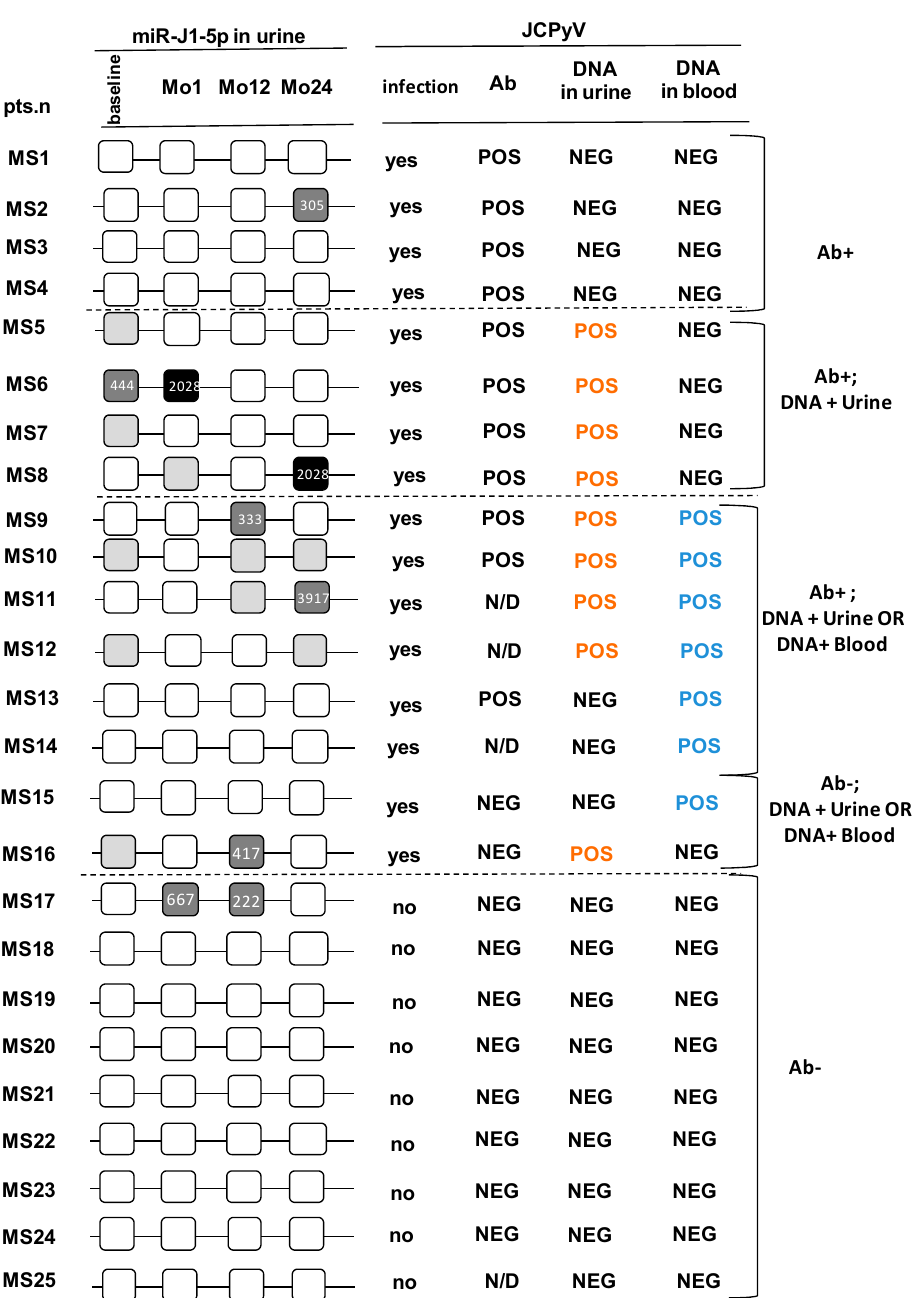
Figure 2. miR-J1-5p and JCPyV DNA detection in urine samples of Natalizumab-treated Multiple Sclerosis patients. Black boxes: positivity for both miR-J1-5p and JCPyV DNA; dark grey boxes: miR-J1-5p positivity alone; light grey boxes: JCPyV DNA positivity alone; white boxes: absence of both nmiR-J1-5p and JCPyV DNA. miR-J1-5p copies/ng are indicated inside the boxes. In the right columns the presence of anti-JCPyV Antibodies (Ab) and JCPyV DNA for each patient is shown. For the exact timing of DNA viral detection in urine and blood, please see Table S1. Mo: Month; pts.n: patient number; N/D: not defined; MS: Multiple Sclerosis; POS: positive; NEG: negative.